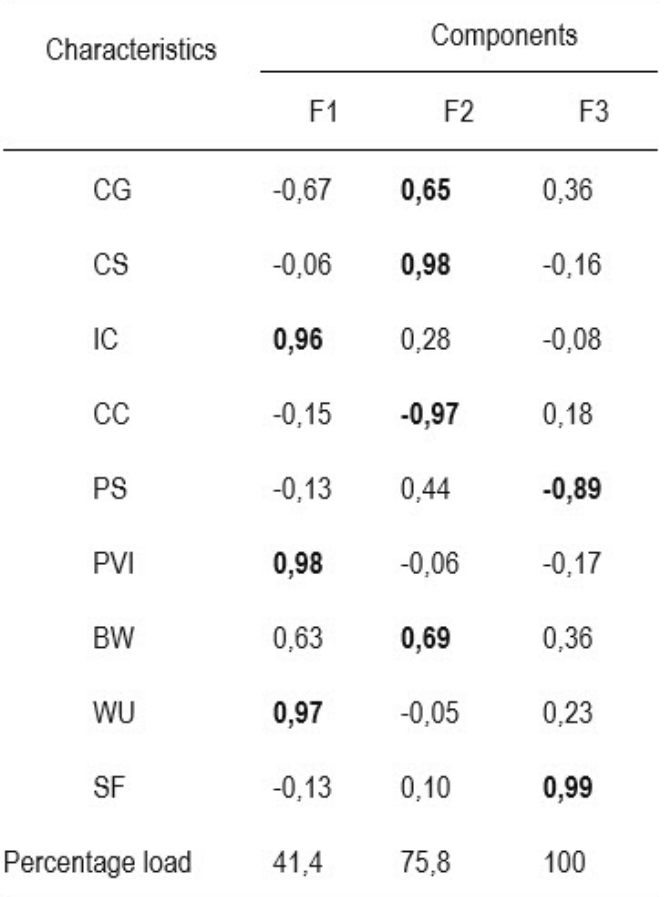
Factor structure of the students’ semantic, categoric and conceptual abilities indices coherence with their basic beliefs ones (group 5 - with extraordinary